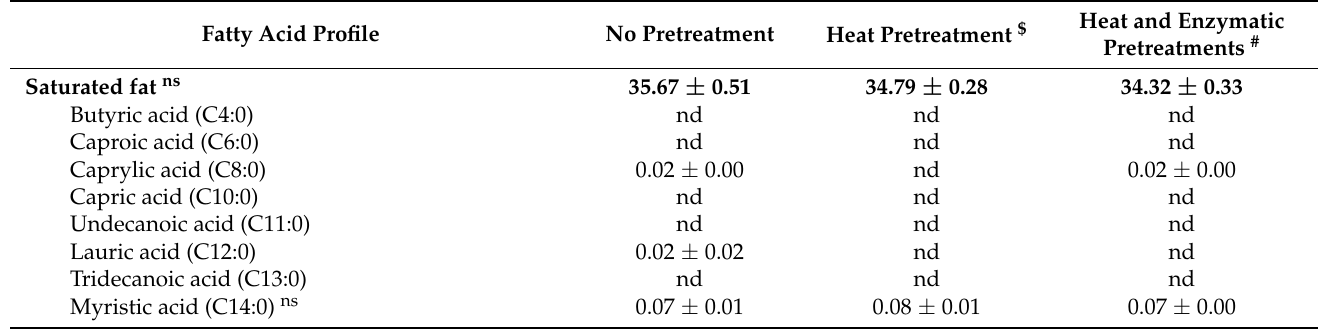
Table 7. Fatty acid composition (g/100 g) and omega-3,6,9 fatty acids (mg/100 g) of H. heteroclita seed oils under different mechanical extraction pretreatment